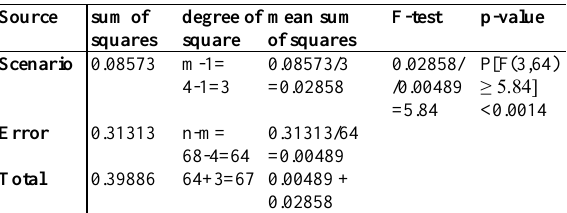
Table 5. ANOVA results for 4 scenarios.